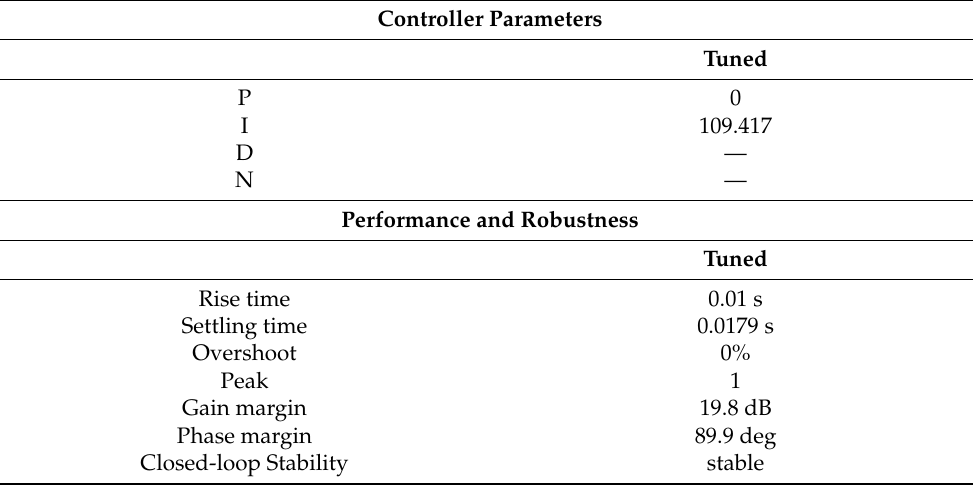
Table 1. Details of the designed linear